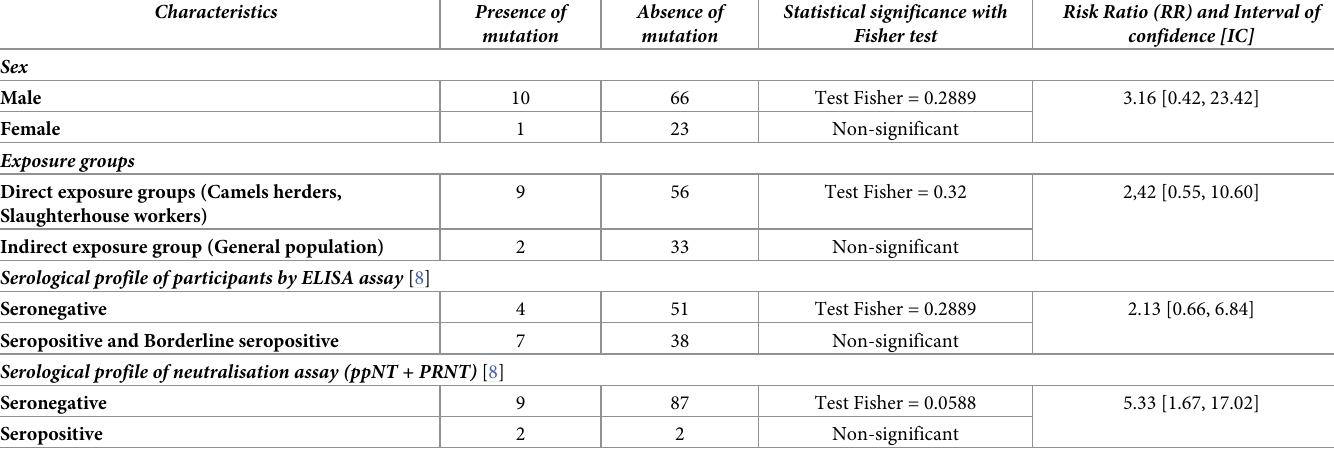
Table 4. Statistical significance for association of sex, type of exposure and seropositivity with the presence of a mutation in the receptor DPP4 binding residues according to the Fisher and Risk Ratio